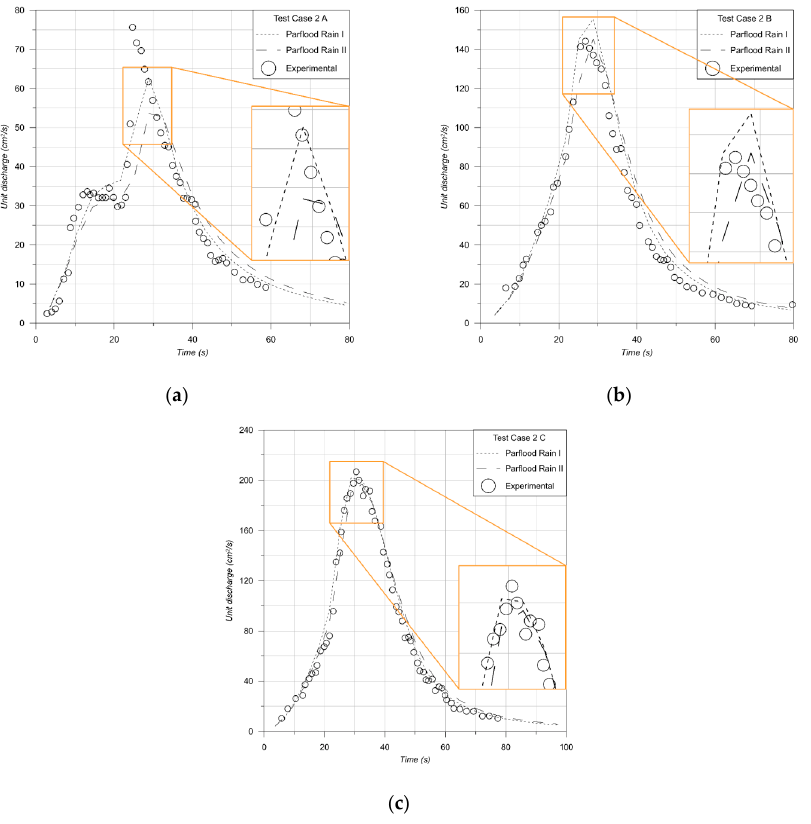
Figure 4. Results obtained through the complete hydrodynamic model (tests I and II) compared to the experimental data ([67]) for different rainfall durations: ( a ) t = 10 s, ( b ) t = 20 s and ( c ) t = 30 s.